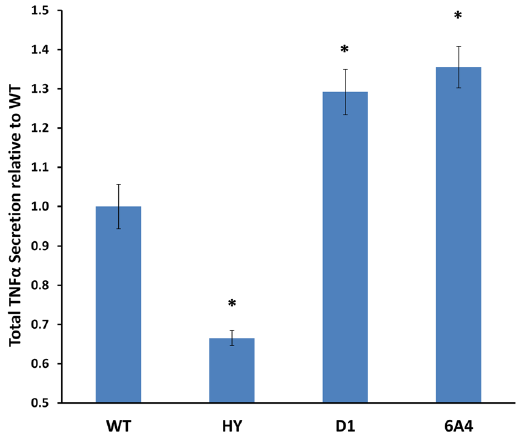
Figure 3. SIRT6 mutants lead to enhanced TNF α secretion to the medium. KO SIRT6 293T were co- transfected with human TNF α and SIRT6 variants. Secretion of TNF α to the medium was measured using ELISA and normalized to the expression of each SIRT6 variant using western blot analysis followed by Image J quantification of the level of each SIRT6 variants. The data presented is the average of three technical repeats of each experiment while the error bars represent the standard deviation from the average. Statistically significant differences of the different SIRT6 variants or the KO from the WT TNF- α secretion levels are labeled with black star (p <